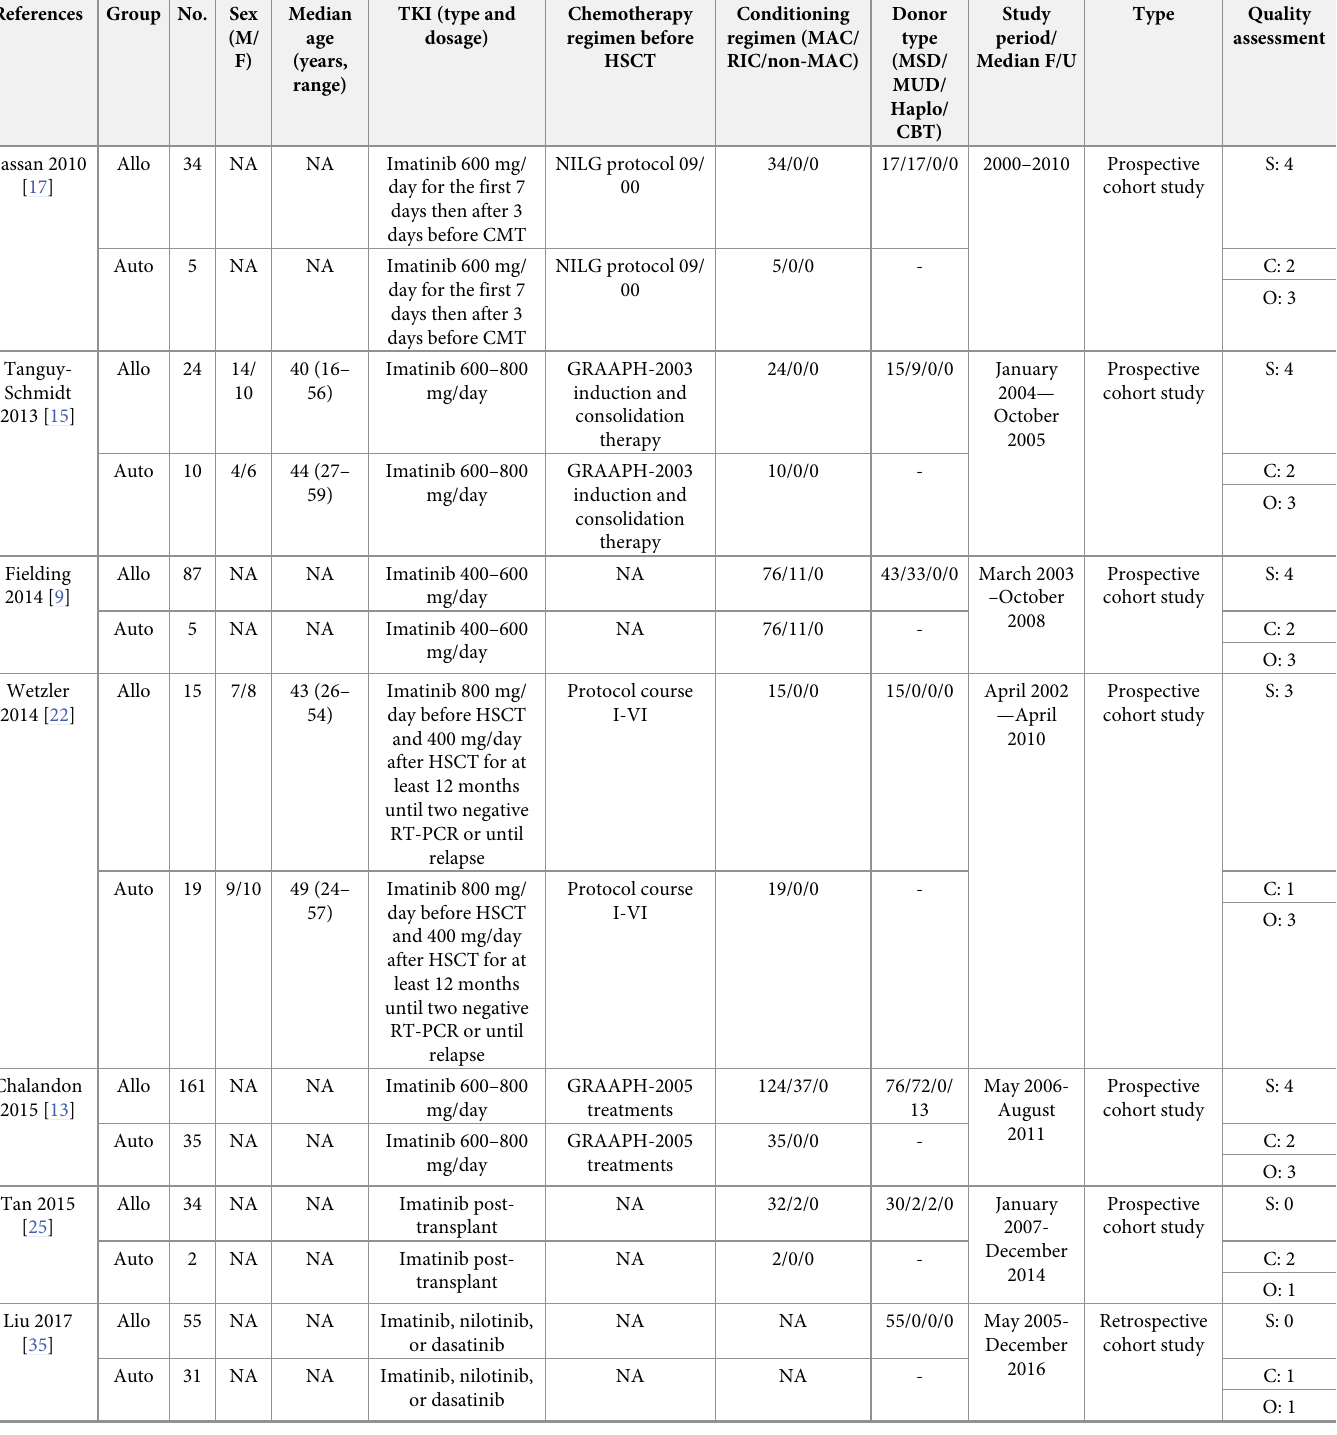
Table 2. Characteristics and participants of studies that compare allogeneic HSCT to autologous HSCT. References Group No. Sex